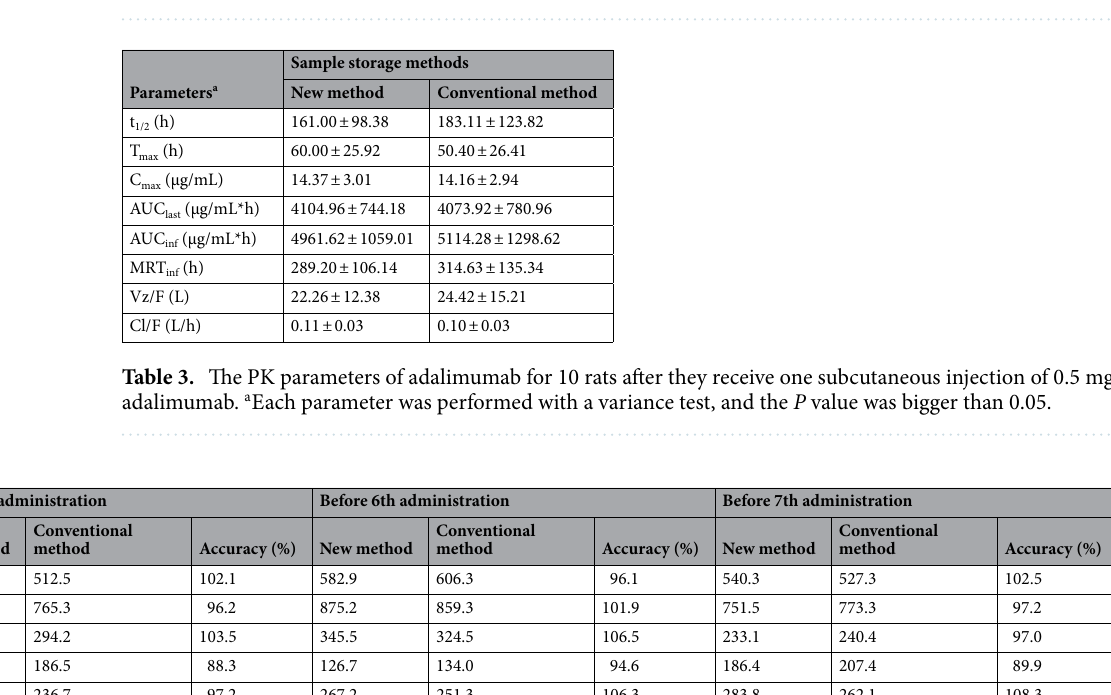
Figure 2. The concentration–time profiles for 10 rats (NO. 1–10) after they receive one subcutaneous injection of 0.5 mg adalimumab. 0.5 ml blood was collected before and at 0.5, 1, 2, 6, 12, 24, 48, 96, 168, 264, 336, and 504 h. Serum samples were separately stored using the new (red symbols and line) or the conventional method (black symbols and line) until analysis. All samples were detected with the ELISA method.